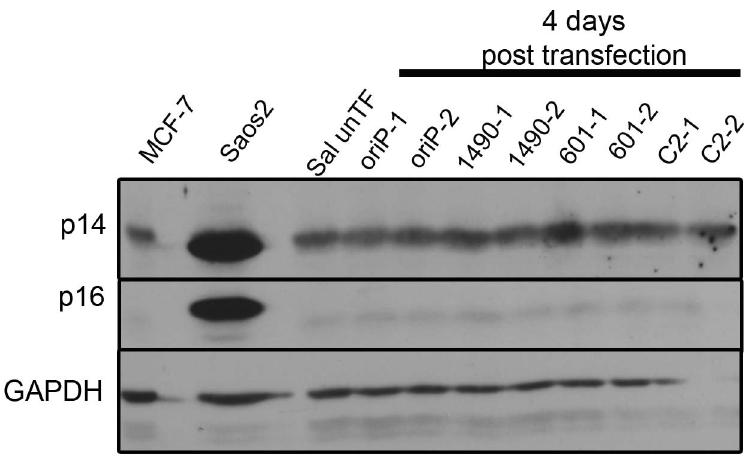
Figure 5. EBNA-3A does not repress p14 ARF or p16 INK4a expression in in Wp-R BL. The levels of p14 ARF and p16 INK4a in Sal BL were analyzed at 4 days post-transfection and not detected. Sal cells were transfected in duplicate with expression vectors for either EBNA-3A-specific shRNA 1490 or 601, control shRNA (C2) or empty vector (oriP). Saos2 and MCF7 serve as positive controls for detection of p14 ARF and p16 INK4a ; GAPDH, loading control. Knockdown of EBNA-3A was similar to that shown in Figure 2A.